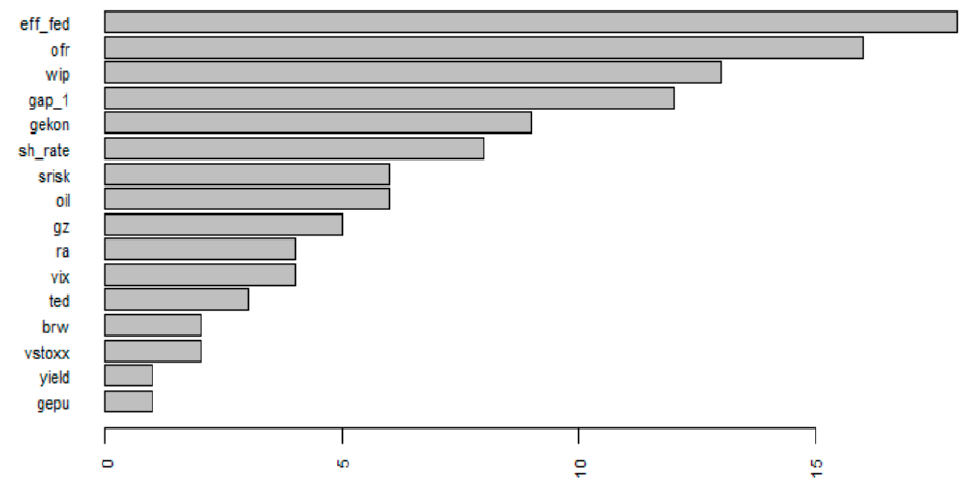
Figure 3. Variable importance ranking for 2014Q1:2021Q1.